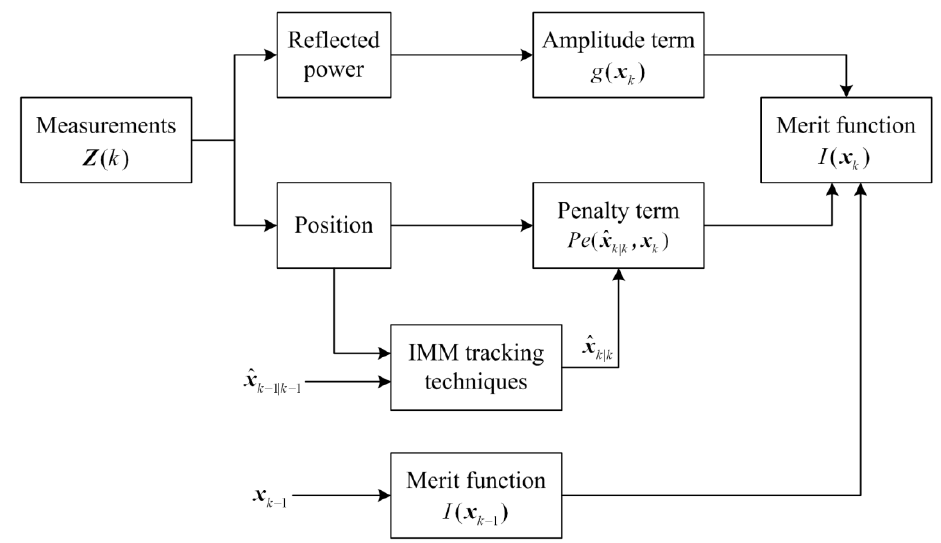
Figure 1. Merit function calculation block diagram at scan k